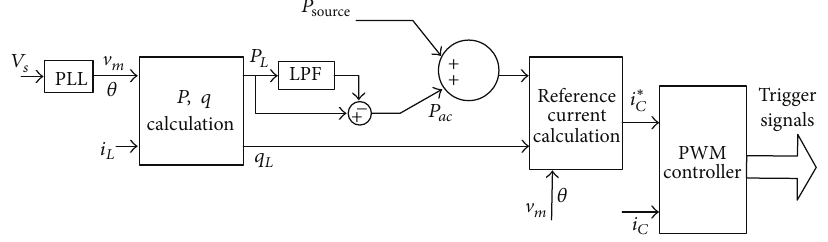
Figure 5: Control block diagram of the capacitive-coupling VSI.